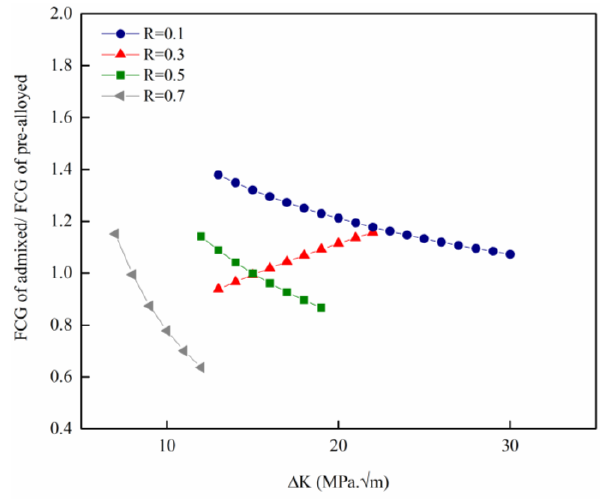
Figure 5. Variation of the fatigue crack growths’ (FCGs’) ratios (admixed/pre-alloyed) against ∆ K in the Paris regime.